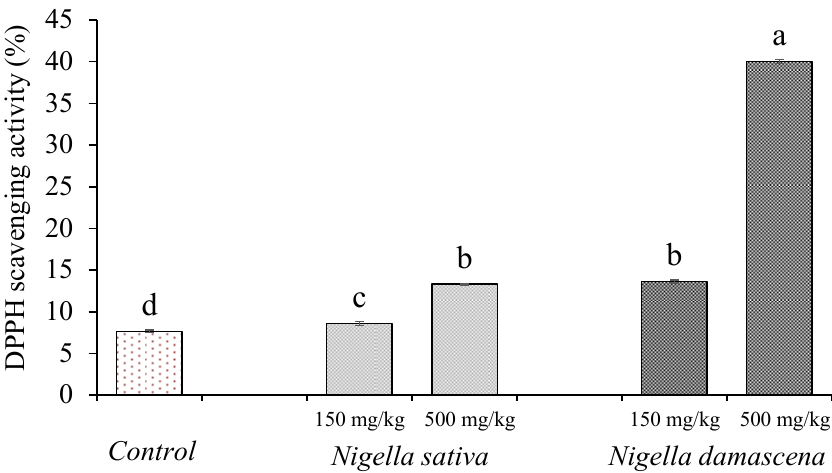
Figure 5. Plasma antioxidant capacity toward DPPH radical for different mice groups. Values are the means ± SEM. Results with different letters are statistically different (Test-LSD, p < 0.05, a > b > c > d). Control, group of mice treated with the 0.9% saline solution; Nigella sativa , two groups of mice treated with the extract of Nigella sativa L. (150 mg/kg body weight for NS1 and 500 mg/kg body weight for NS2); Nigella damascena , two groups of mice treated with the Nigella damascena L. extract (150 mg/kg of body weight for ND1 group and 500 mg/kg of body weight for ND2 group).